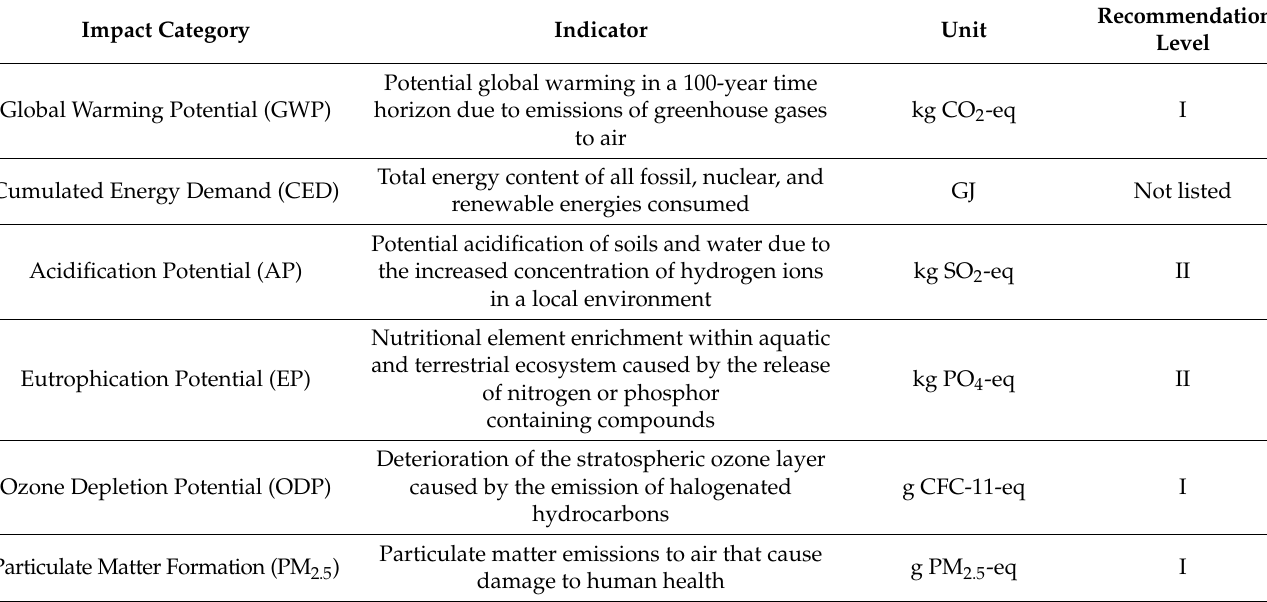
Table 10. Suggested impact categories for CCUS. Adapted from